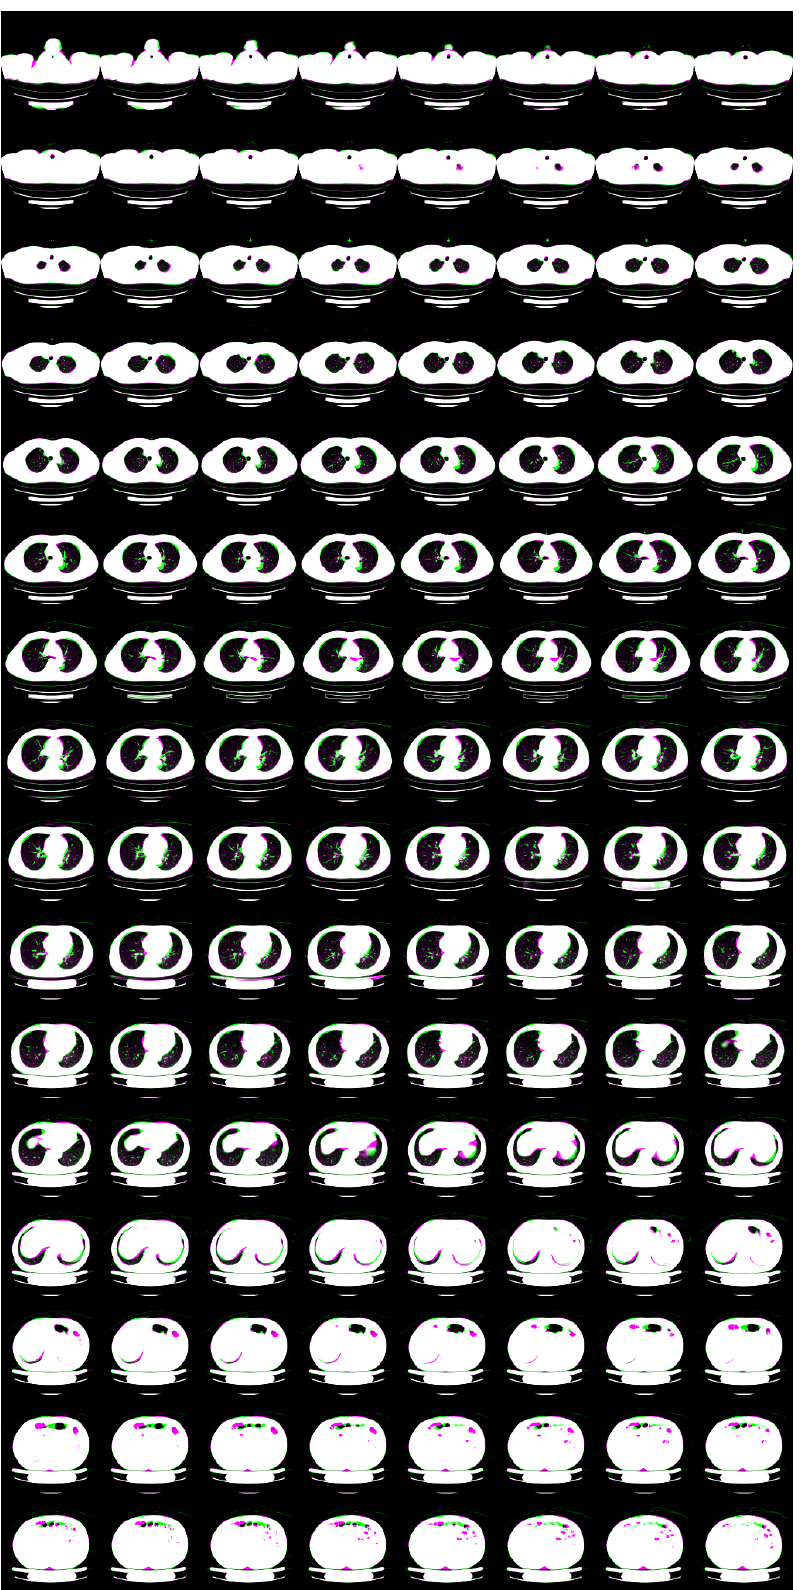
Figure 5. Superposition of the reconstructed 3D CT image shown in Figure 4 (magenta) and the ground-truth image